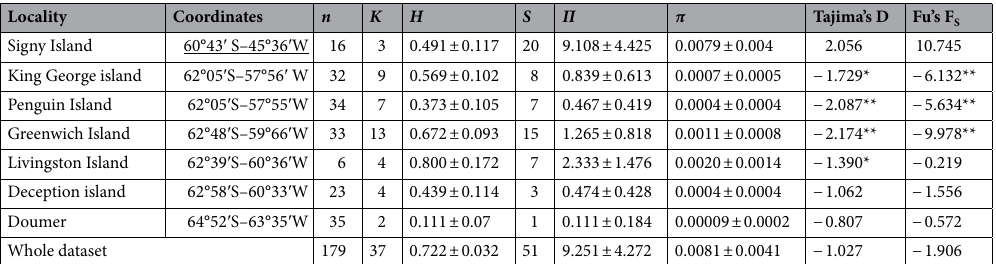
Table 1. Geographic information and standard genetic statistics of Kidderia subquadrata sampling localities. n = number of individuals; k = number of haplotypes; S = polymorphic sites; H = haplotype diversity; Π = mean number of pairwise differences π = nucleotide diversity. p value (*) > 0.05; (**) >